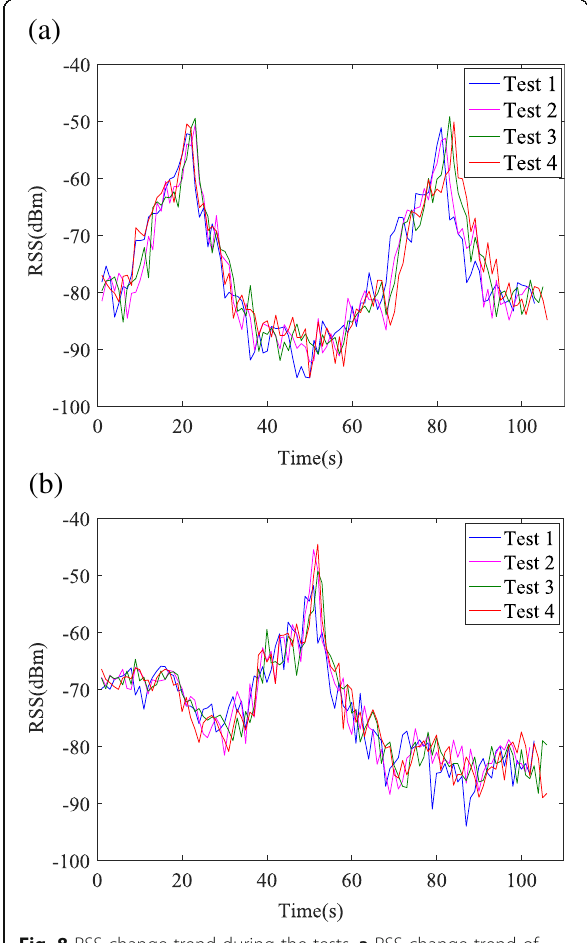
Fig. 8 RSS change trend during the tests. a RSS change trend of Anchor 2. b RSS change trend of Anchor